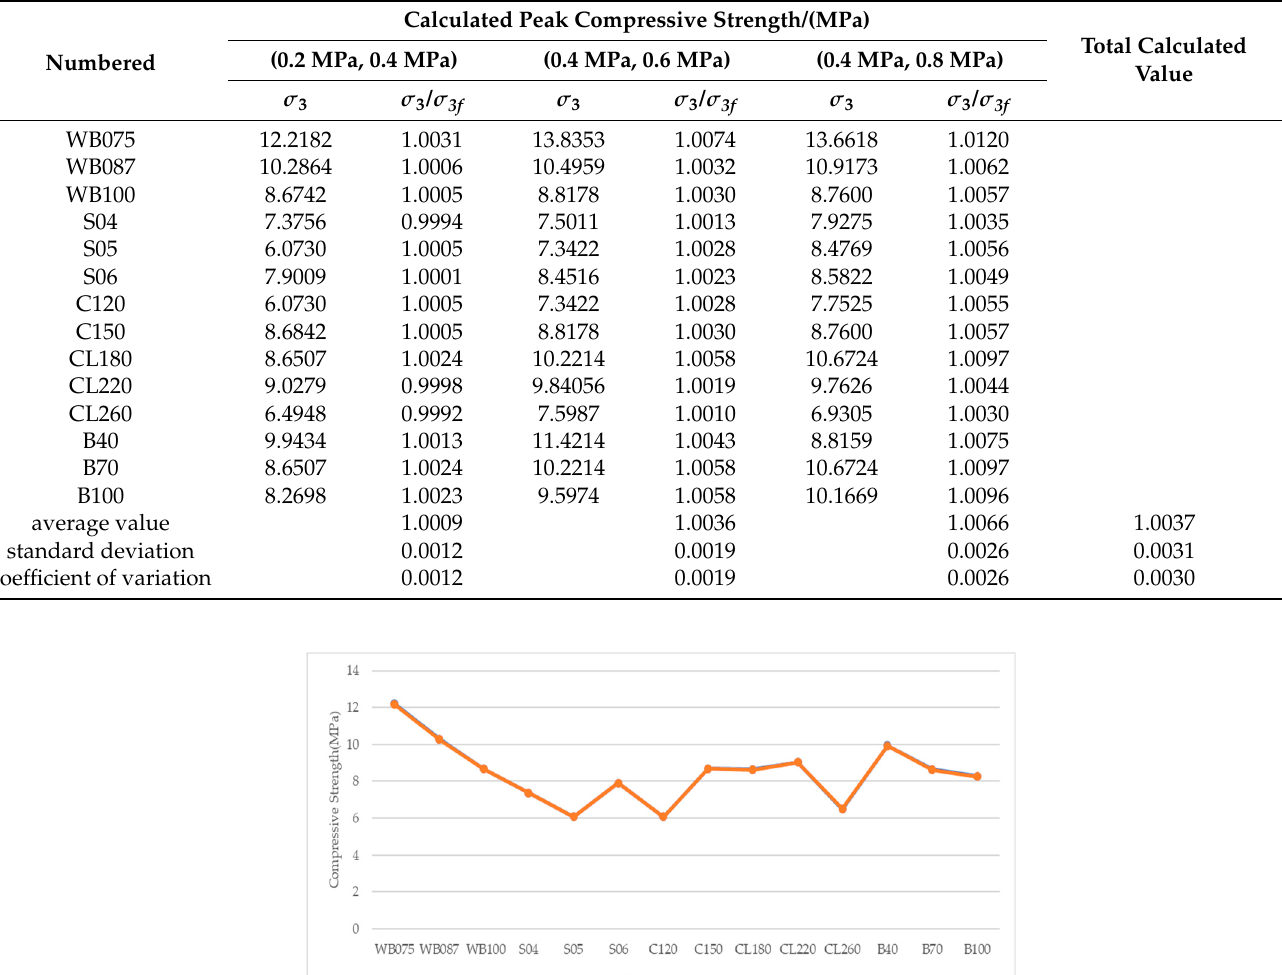
Table 6. Comparison of Peak Compressive Strength between Calculation and Test.